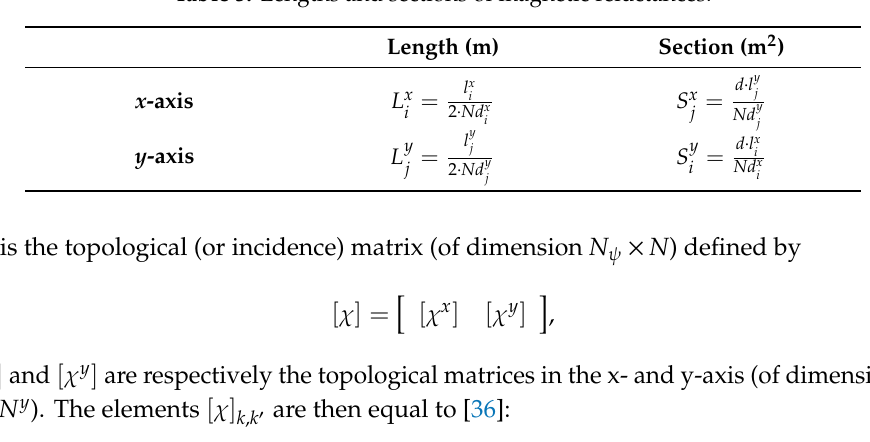
Table 3. Lengths and sections of magnetic